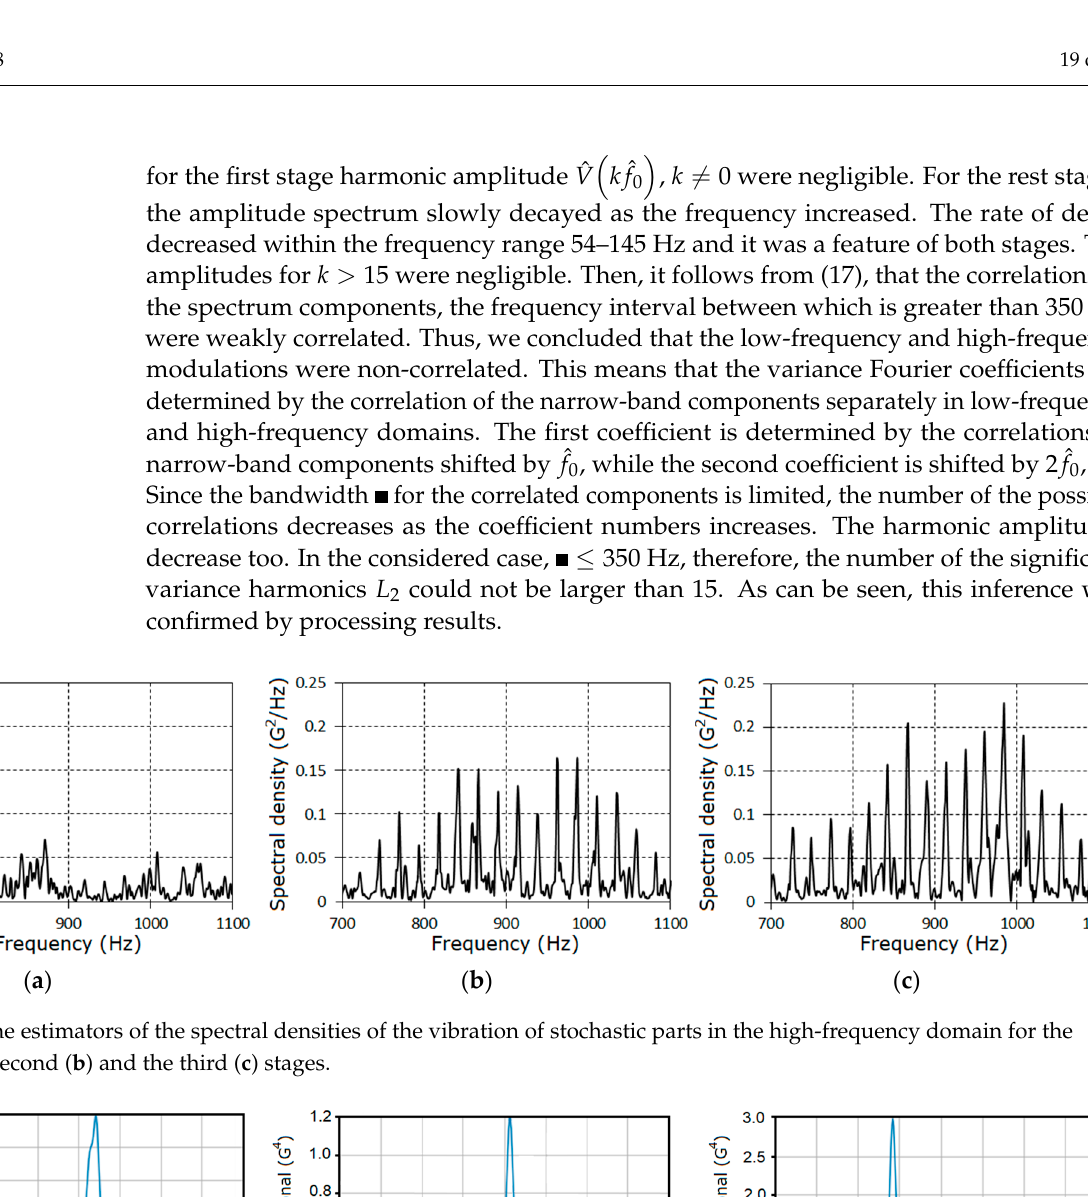
Figure 9. The estimators of the covariance function of the vibration of stochastic parts for the first ( a ), the second ( b ) and the third ( c ) stages.